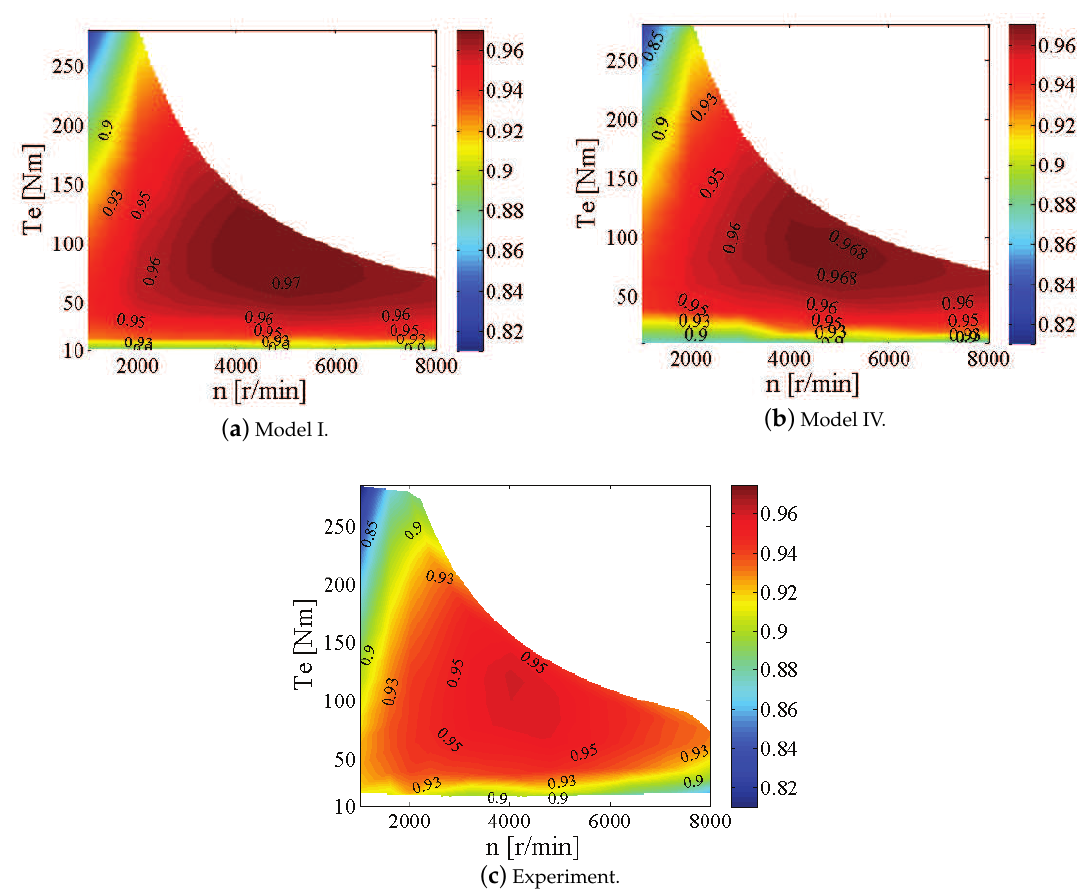
Figure 15. Efficiency map of ( a ) Model I, ( b ) Model IV, and ( c ) the